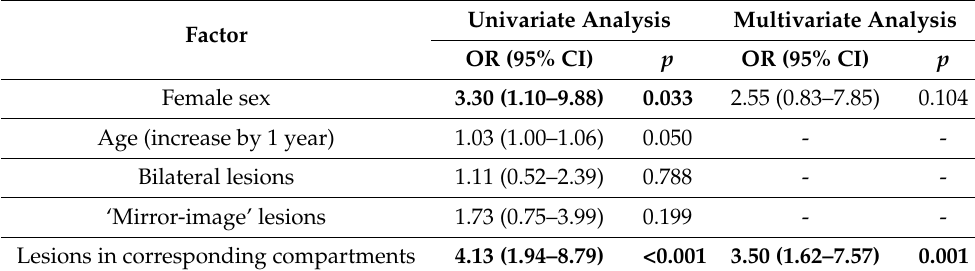
Table 11. Logistic regression for the dependent variable of seronegative RA vs. the independent variable of PsA considering the types of symmetry.